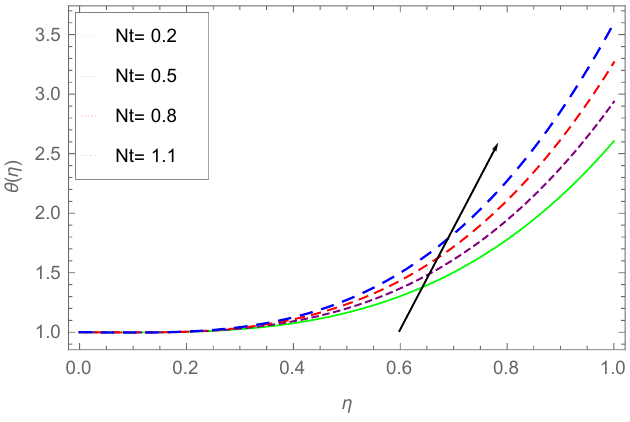
Figure 9. Impact of Nt on θ ( η ) , for β = 0.1, St = 0.1, Rd = 0.2, Nb =